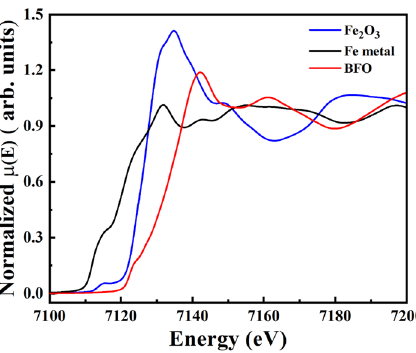
Figure 5. X-ray absorption spectra of Bi 12 FeO 20 near Fe-K edge position as compared with standard metallic Fe and Fe 2 O 3